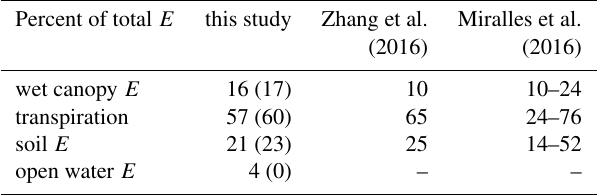
Table 4. Estimated percentage of total (or primary between brack- ets) terrestrial evaporation ( E) contributed by different pathways, compared with estimates from two recent